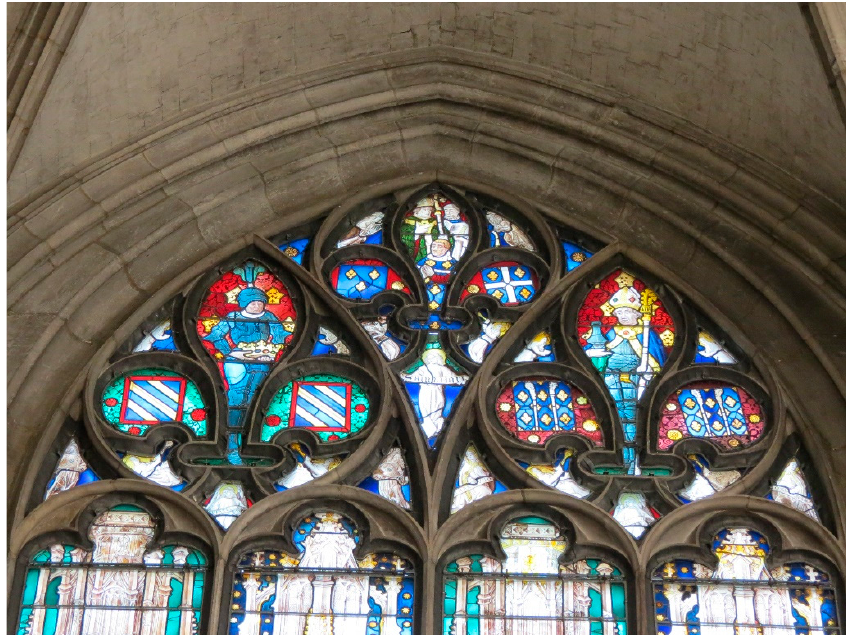
Figure 4. Coronation of Louis XI in Reims , stained-glass window, 1469, Evreux, Evreux cathedral, axial chapel, bay Source: Wikimedia Commons, CC BY-SA 4.0 license.